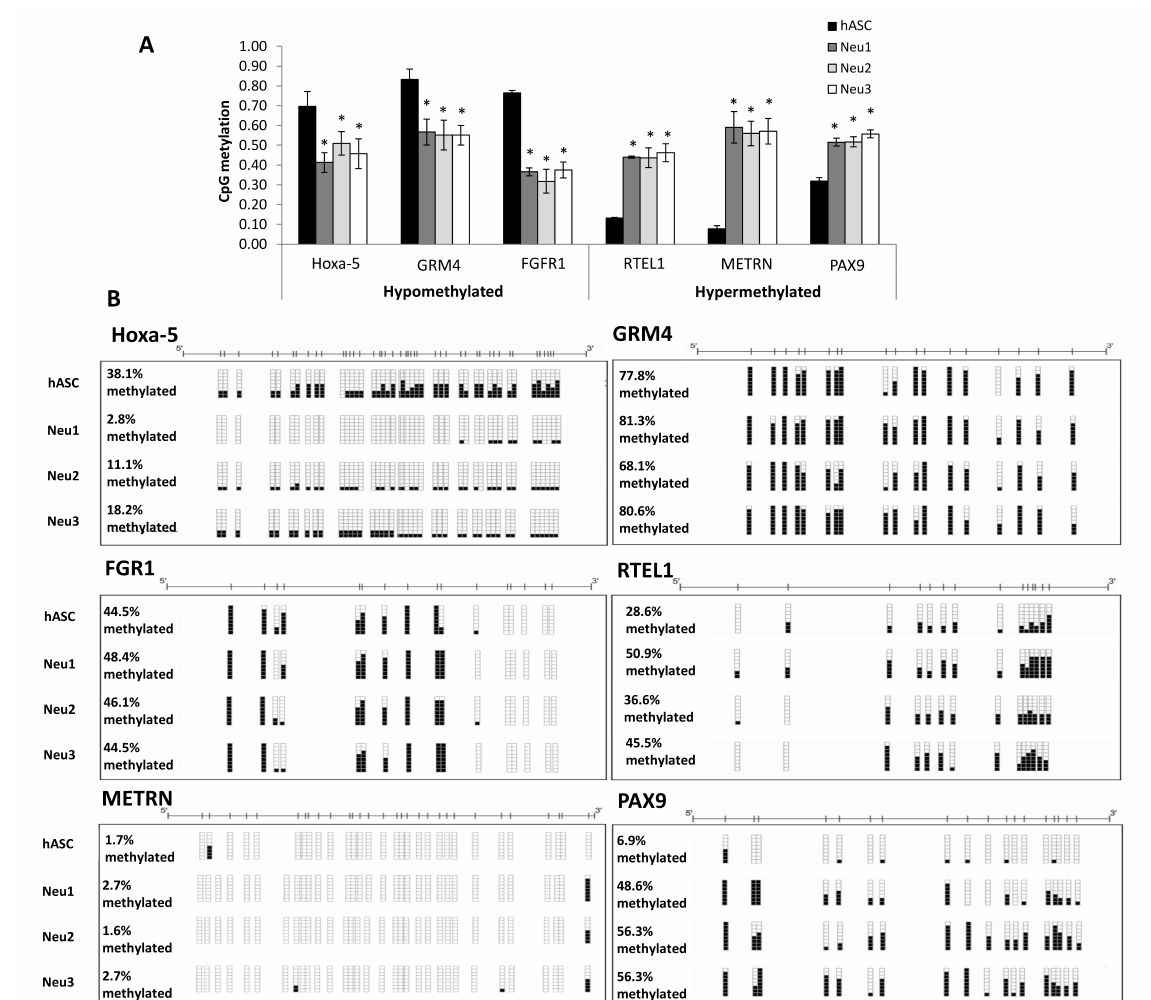
Figure 4. Promoter methylation studies of gene candidates. ( A ) Promoter methylation arrays of the Hoxa5, GRM4, FGFR1 (hypomethylated) and RTEL1, METRN, and PAX9 (hypermethylated). Statistically significant differences (Student’s t -test) (*) with respect to the control ( p ≤ 0.05). ( B ) Validation of microarray results by bisulfite genomic sequencing of the promoter region of the same genes after differentiation with Neu1, Neu2, and Neu3. The results of bisulfite genomic sequencing of eight individual clones are shown, in which CpG dinucleotides are represented as short vertical lines. The presence of a methylated or unmethylated cytosine is indicated by a black or white square,